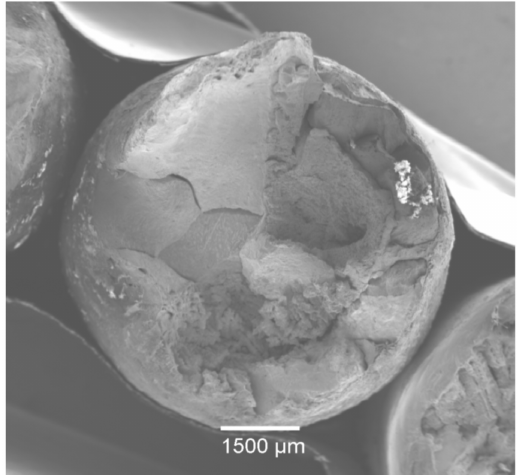
Figure 12. “Rock candy” fracture in a 1.05% Al containing TRIP steel [28]. The composition of the TRIP steel was 0.15% C, 2.45% Mn, 0.025% Nb, 0.005% S, 0.0065%